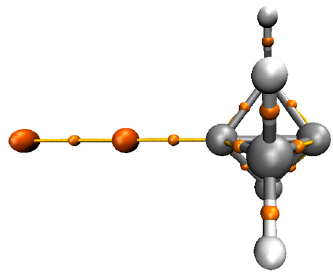
Figure 3. Atoms in molecules (AIM) diagrams of P-Cu 2 . Table 2. Electron density ( ρ , a.u.), Laplacian ( ∇ 2 ρ , a.u.), and total energy density (H, a.u.) at the